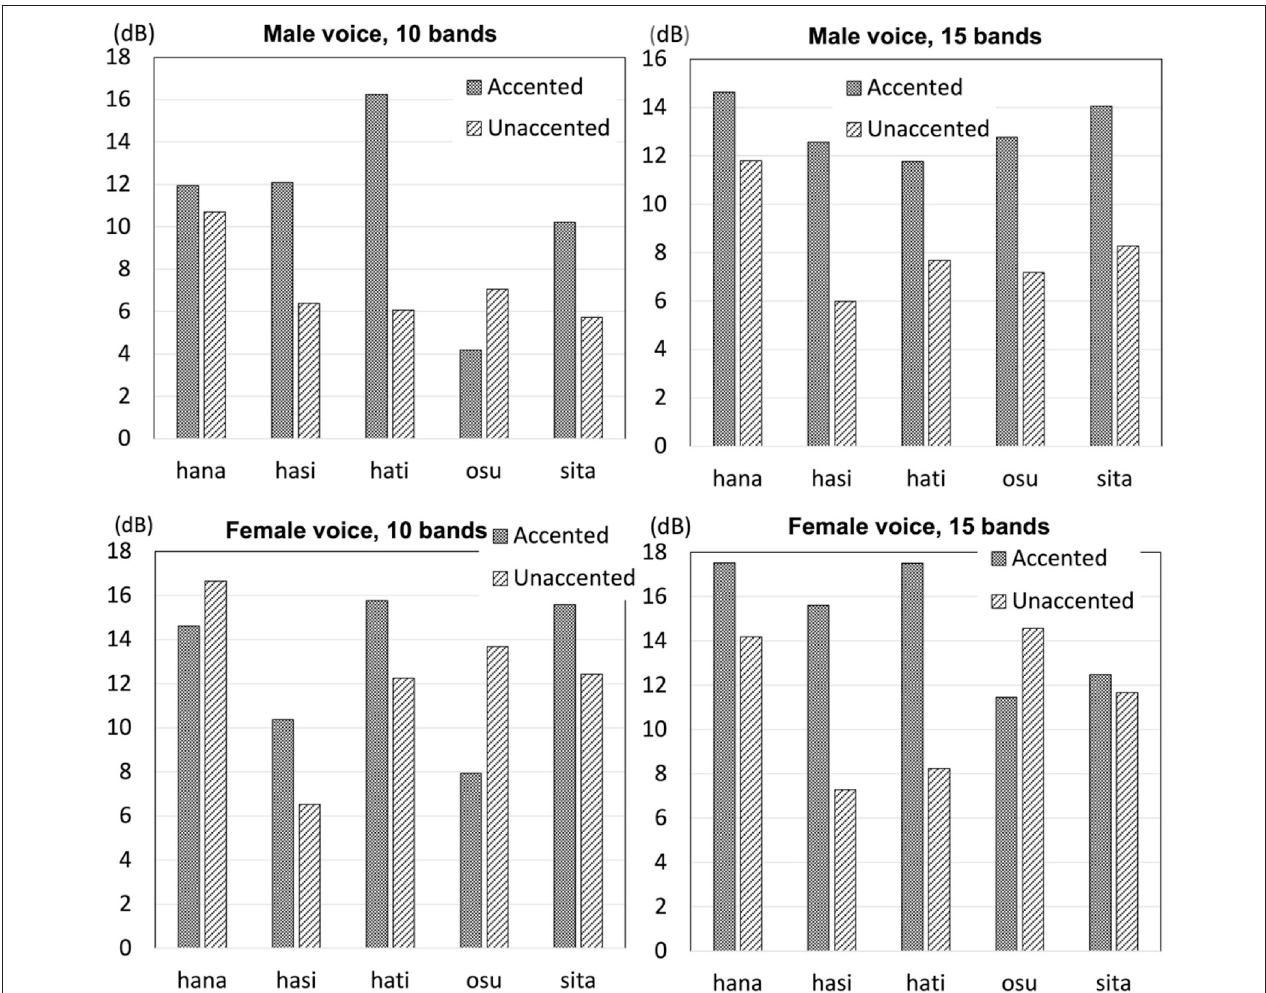
FIGURE 10 | Intensity difference from the word-final syllable to the following particle for the 10 band stimuli and the 15 band stimuli for the male voice and female voice